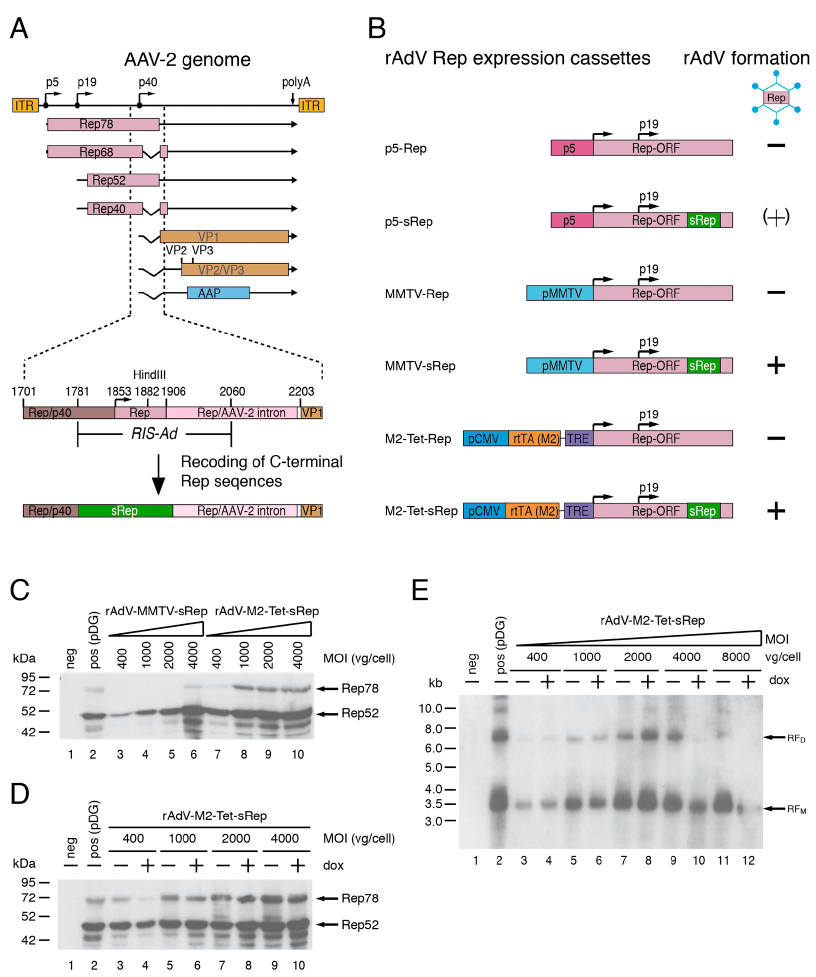
Figure 1. Expression of AAV-2 Rep proteins by first generation recombinant adenoviruses (rAdV) after recoding of the 3 ′ -inhibitory RIS-Ad sequence. ( A ) Genome organization of AAV-2 with a close-up of the RIS-Ad ( Rep inhibitory sequence for adenoviral replication ) in the 3 ′ -part of the rep gene. The AAV-2 inverted terminal repeats (ITRs), the four Rep proteins Rep78, Rep68, Rep52, Rep40, the capsid proteins VP1 to VP3 and the AAP ( assembly activating protein) are indicated by differentially colored boxes. The box “sRep” in the lower part of the figure indicates recoding of AAV-2 nucleotides 1782 to 1916 sufficient for abolishing the inhibitory function of the RIS-Ad. Characteristic nucleotide positions are given above the boxes. ( B ) Schematic presentation of the transgene cassettes of the adenoviral shuttle plasmids tested. Formation of rAdV after transfection of the corresponding PacI-linearized pAdEasy plasmids into HEK293 cells is indicated by “+” and “ − ” signs. ( C ) Anti-Rep Western blot analysis after infection of HEK293 cells for 64 h with rAdV-MMTV-sRep (amplification round 5) and rAdV-M2-Tet-sRep (round 6) at the indicated MOIs (genomic particles/cell). Transfection of pDG plasmid (transfection efficiency about 70%) was used as positive control. ( D ) Anti-Rep Western blot analysis after infection of HEK293 cells with rAdV-MMTV-sRep as in ( C ) in the absence and presence of doxycycline. ( E ) Southern blot analysis for rAAV replicative DNA intermediates after transfection of HEK293 cells with pTR-UF5 and over-infection with rAdV-M2-Tet-sRep in the absence or presence of doxycycline at the indicated MOIs for 64 h. The positive control in lane 2 represents pTR-UF5/pDG co-transfected